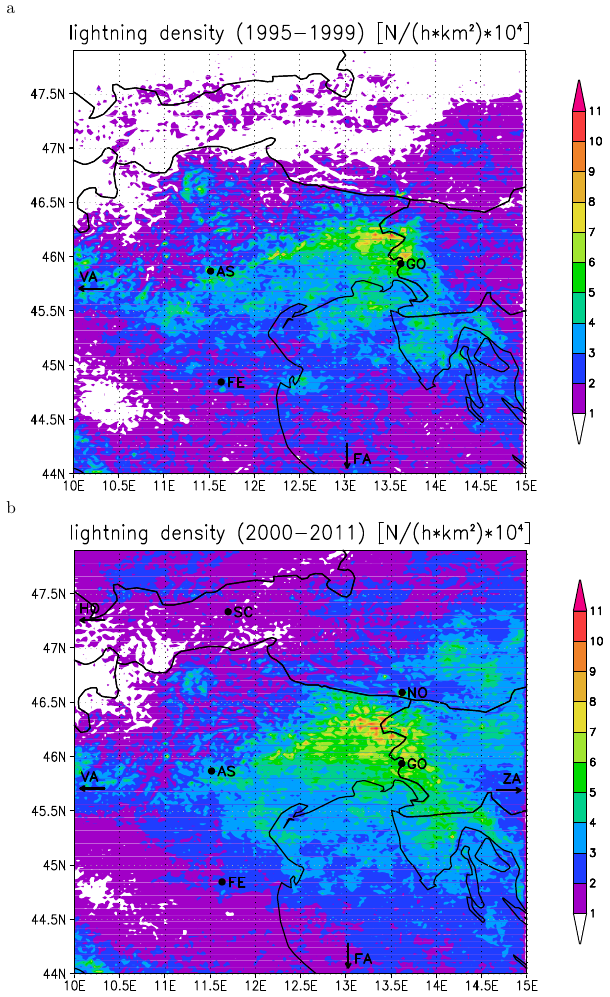
Figure 1. Lightning density and location of lightning detection sensors in the studied domain, for the period a) 1995–1999 and b) 2000–2011. Sensors in Italian domain: AS = Asiago, FA = Fano, FE = Ferrara, GO = Gorizia, VA = Varese. Sensors outside the Italian domain: HO = Hohenems (A), NO = Notsch (A), SC = Schwatz (A), ZA = Zagreb (HR).